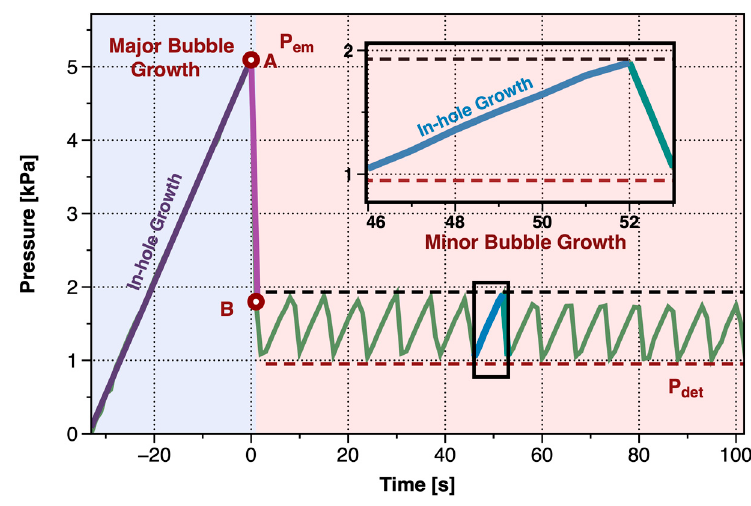
Figure 3. Pressure curve of the gas injection test.